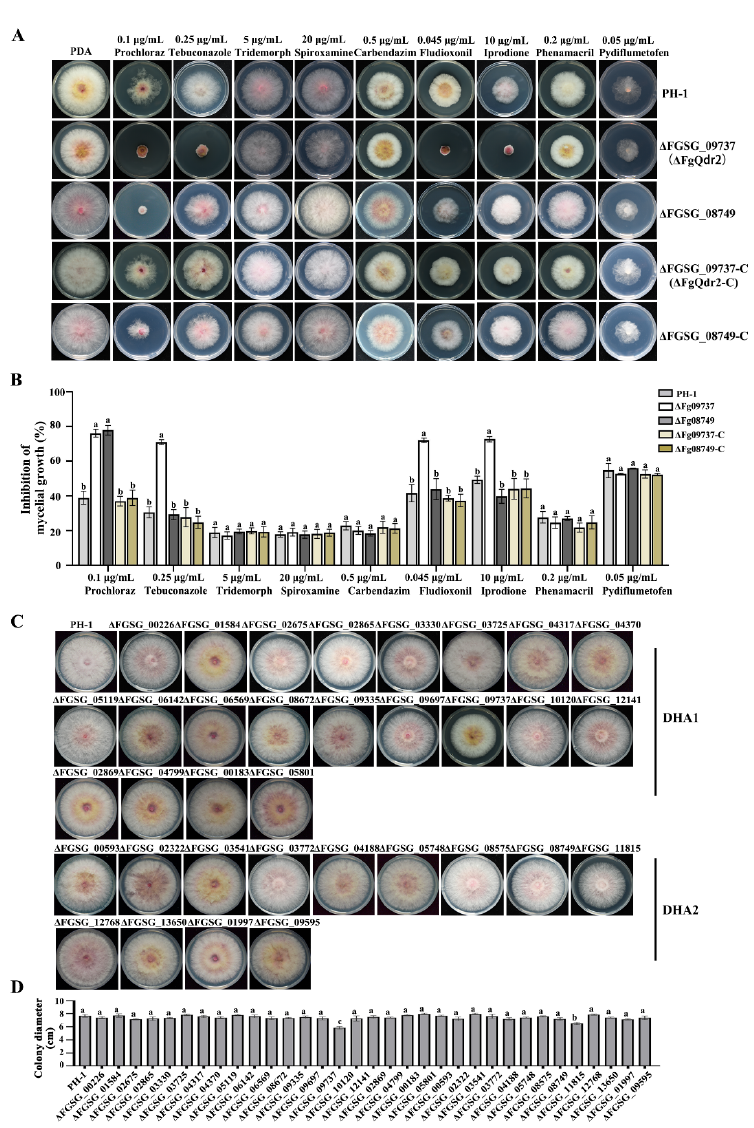
Figure 1. FgQdr2 is required for multiple drug resistance and mycelial growth in F. graminearum . ( A ) Sensitivity of each strain to 9 commonly used fungicides. ΔFGSG_09737 (ΔFgQdr2) exhibited increased sensitivity to prochloraz, tebuconazole, fludioxonil, and iprodio ne, and ΔFGSG_08749 showed in- creased sensitivity to prochloraz. Each strain was cultured on PDA, and PDA amended with 0.1 ppm prochloraz, 0.25 ppm tebuconazole, 5 ppm tridemorph, 20 ppm Spiroxamine, 0.5 ppm carbendazim, 0.1 ppm fludioxonil, 10 ppm iprodione, 0.2 ppm phenamacril, and 0.02 ppm pydiflumetofen. The images were taken after 3 d incubation at 25 °C, and the mycelial growth inhibition was calculated for each strain. ( B ) The mycelial growth inhibition of each strain under the above drug treatments. ( C ) Colony morphology of PH-1 and 34 DHA transporter deletion mutants. Colony morphology was observed af- ter culture on PDA for 3 d. ( D ) Colony diameters of PH-1 and 34 DHA transporter deletion mutants. For